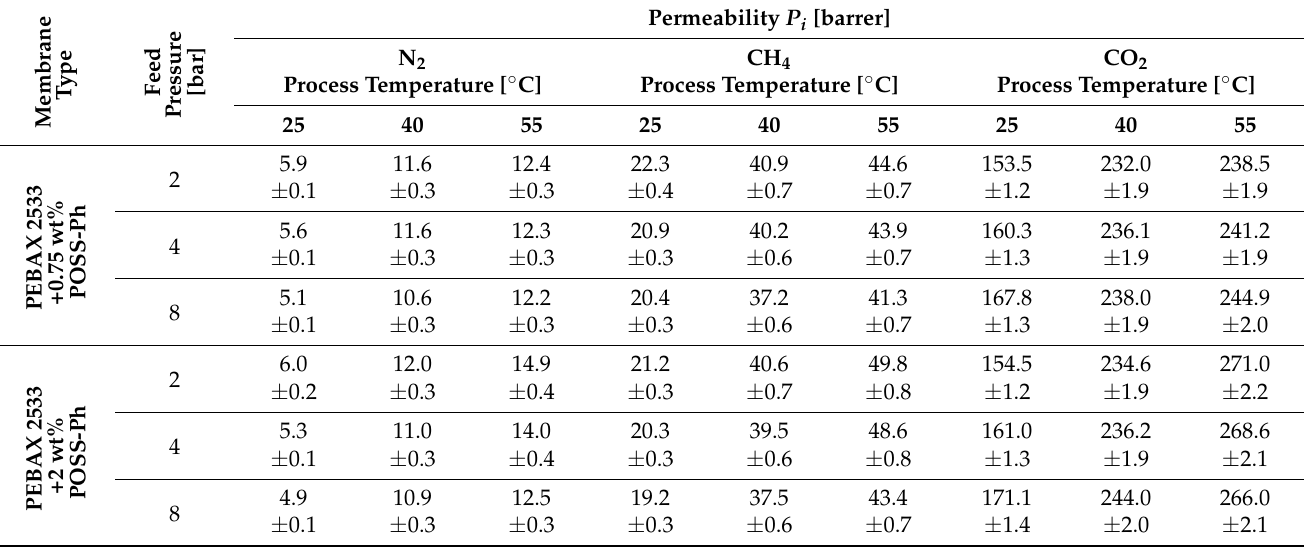
Table A4. Permeability of heterogeneous membranes containing POSS-Ph to different gases measured for different feed pressure and temperature values.